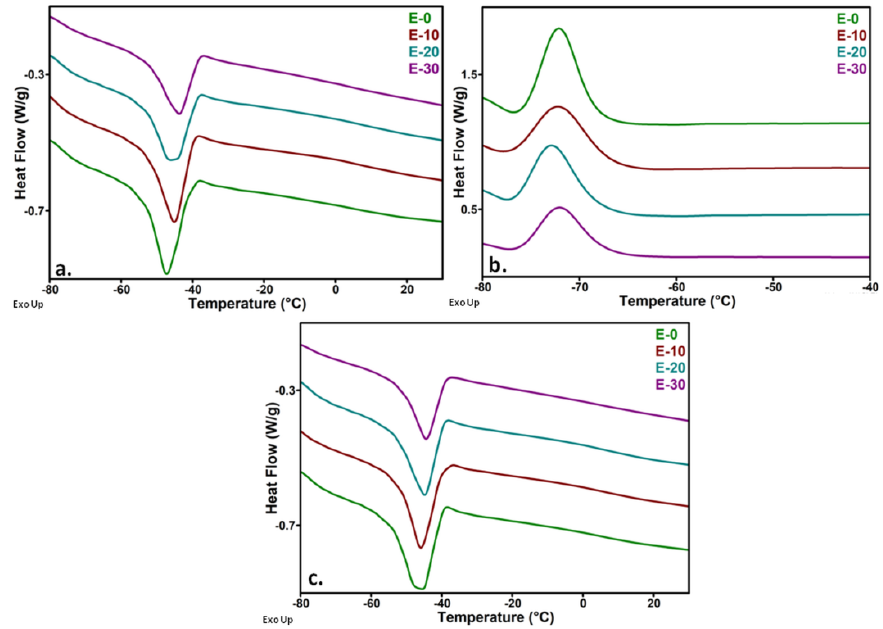
Figure 8. DSC thermograms of nanocomposites from the first heating ( a ), cooling ( b ) and second heating ( c ) cycles.